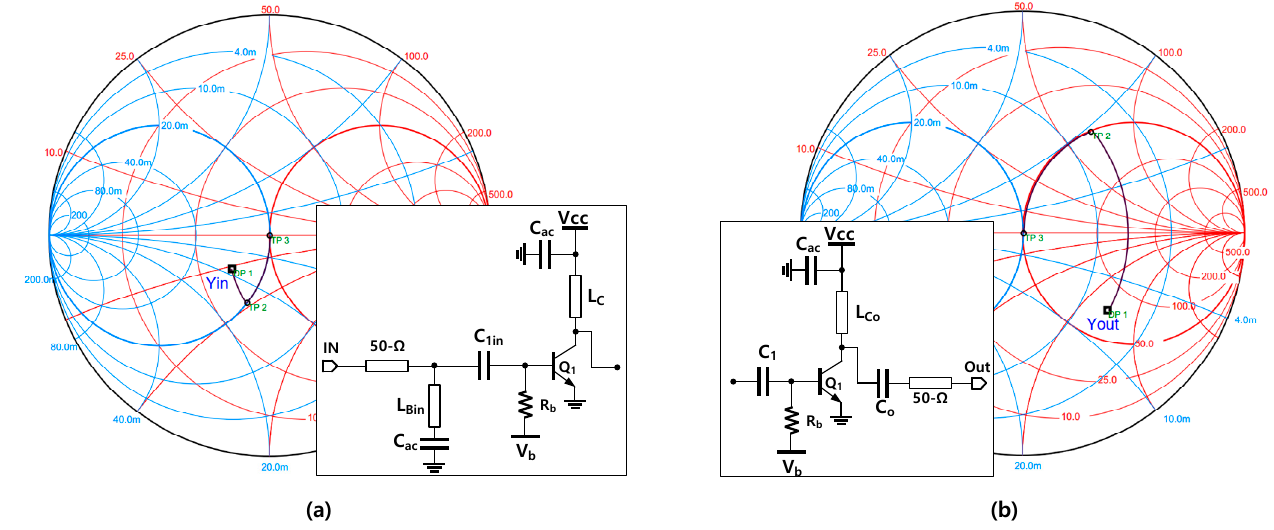
bypass MIM capacitors were used.